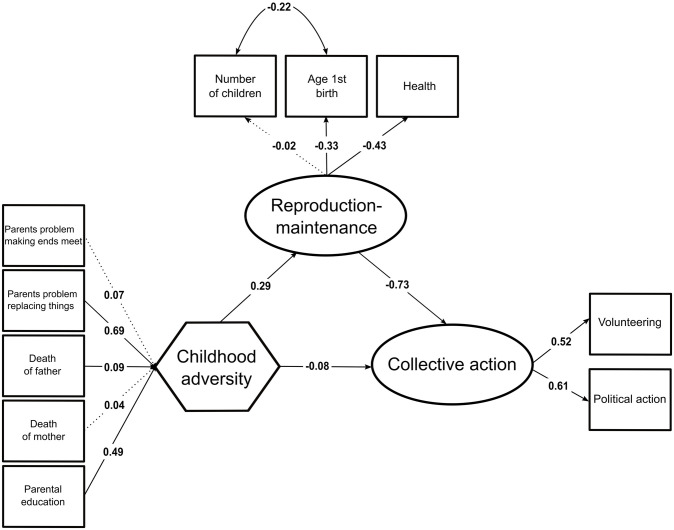
European Values Study standardized parameter values estimated by the structural equation model.Significant paths at the 5% level are represented with a continuous arrow.